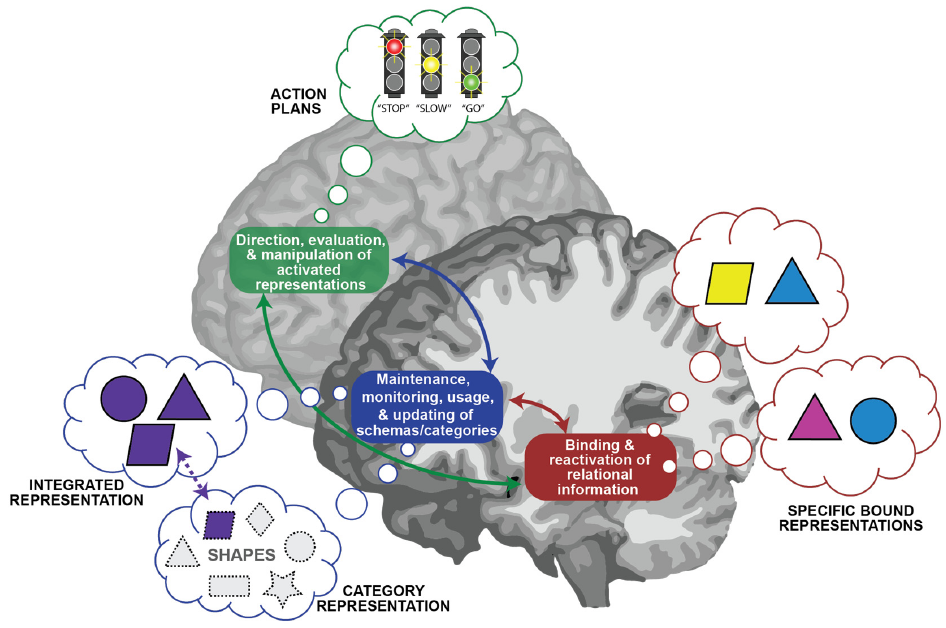
Figure 1. Hippocampal–Prefrontal Cortex (PFC) Network Processes and Representations. Boxes = processes; Thought bubbles = representations; Red box and thought bubbles = mediated by hippocampus; Blue box and thought bubbles = mediated by medial PFC; Green box and thought bubble = mediated by lateral PFC. In this example, the hippocampus supports processes and representations consistent with relational memory theory, permitting the arbitrary binding and later reactivation of various attributes of the event (e.g., spatial, temporal, and associative relations, such as here, which shapes were present and how they were arranged relative to each other). The medial PFC supports the maintenance, monitoring, usage, and updating of more abstract or meaningful information, whereas the lateral PFC supports the direction, evaluation, and manipulation of this information. We suggest medial PFC regions represent information about abstract categories that are related to the elements (in this case, abstract “shape” categories such as stars, rectangles, etc.), as well as integrated representations of the elements across the events (e.g., the combination of shapes in the events, but with less detail of their arrangement relative to each other). We also suggest lateral PFC may maintain representations of action plans and, like a stop signal, inhibit, slow down, or activate/enhance, the simulation of behaviors required to perform a task (e.g., in this case, deciding to initiate movement of the shapes to achieve a particular goal). Further, the processes naturally unfold over time, allowing the representations to be iteratively shaped (i.e., modified, updated) by new experiences.